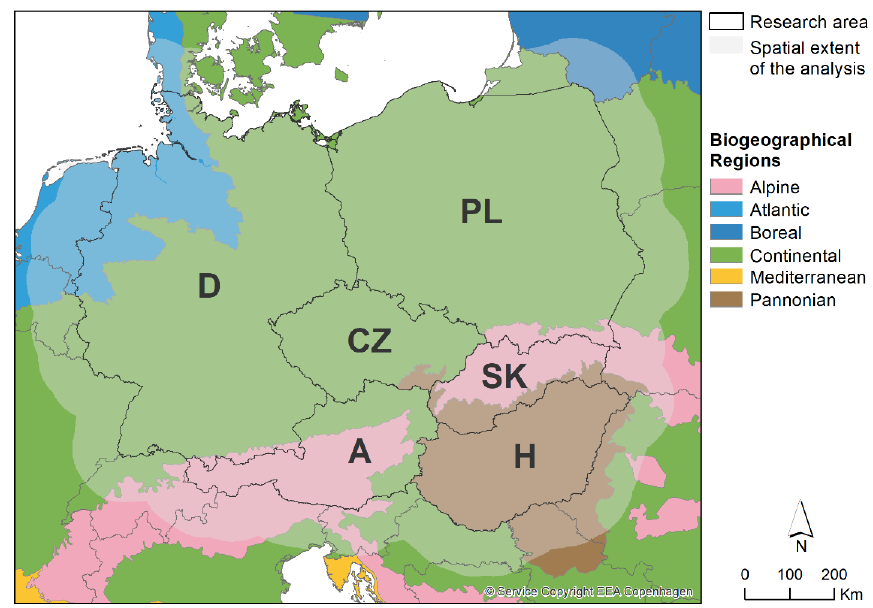
Figure 1. Research area and spatial extent of analysis (light colours). Source of Biogeographical Regions layer: ArcGIS Map Service, © Service Copyright EEA Copenhagen [61].